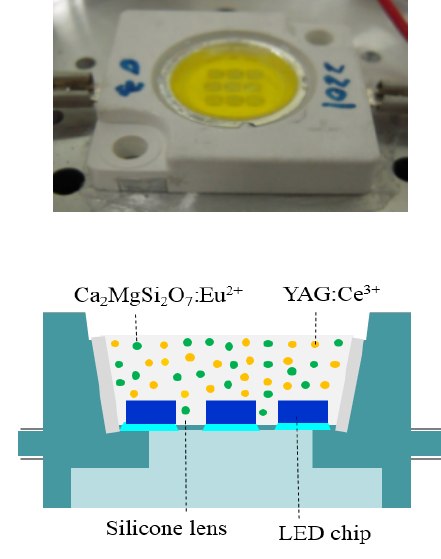
Fig. 1: (top) In-cup phosphor con(cid:28)guration; and (bot- tom) its 2-D illustration. of green-emitting Ca 2 MgSi 2 O 7 :Eu 2+